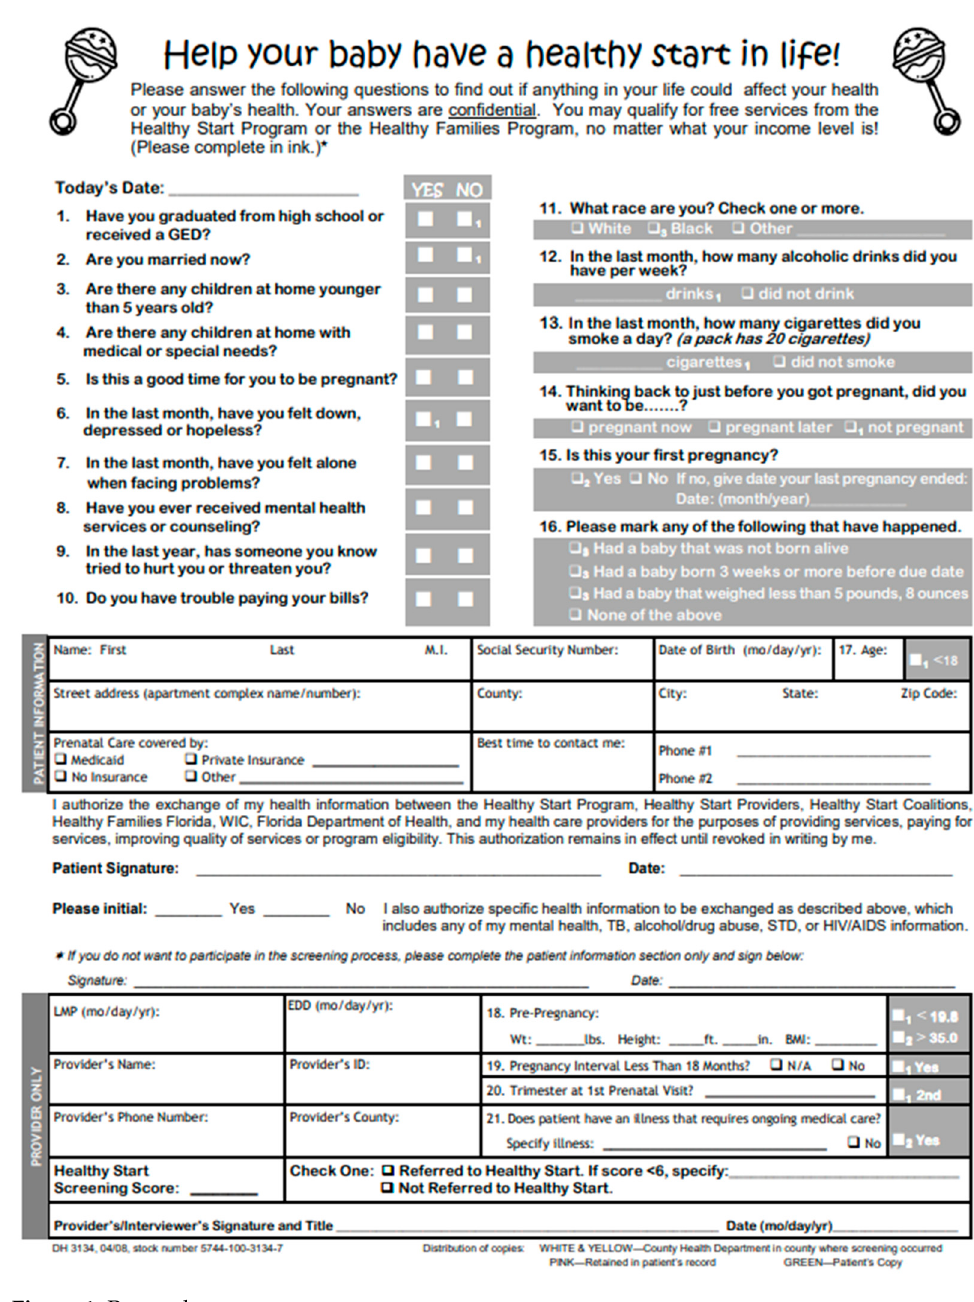
Figure 1. Prenatal Figure 1. Prenatal screen.